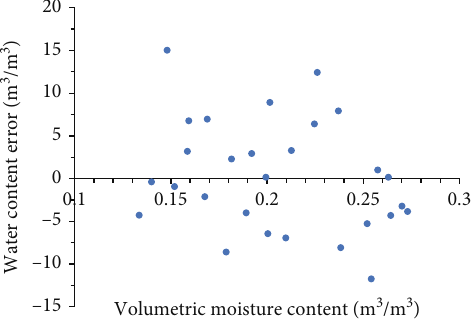
Figure 16: The absolute errors between calculated water contents and measured water contents by the fi tting relational formula.